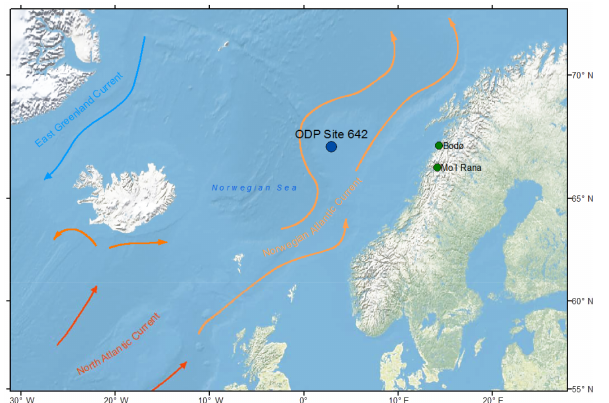
Figure 1. Location of ODP Site 642 in the Norwegian Sea. Mete- orological stations used for present-day climate data are located in Bodø and Mo i Rana in northern Norway. Colour coding indicates the relative temperature of currents: red – warm; orange – moder- ately warm; blue – cold.